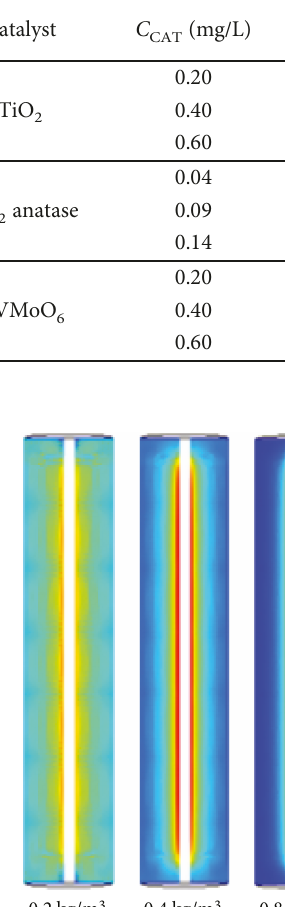
Table 2: Comparison of correlation coe ffi cients of di ff erent radiation absorption models for studied systems.